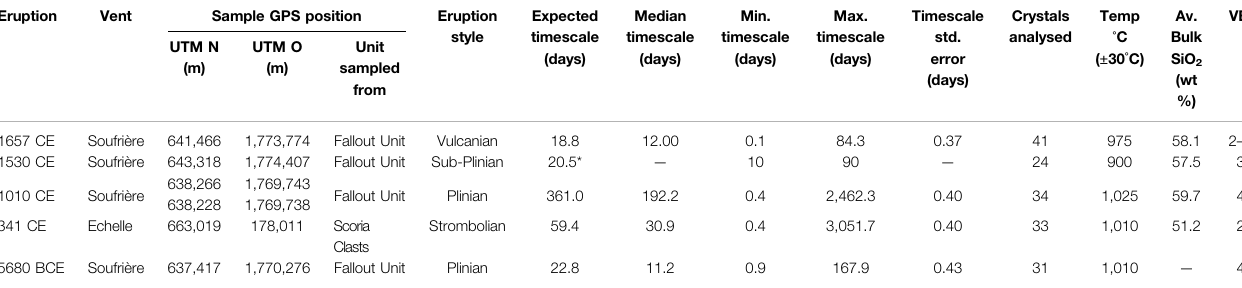
TABLE 2 | Summary table for the eruptions showing the key features for each eruption and sample location.